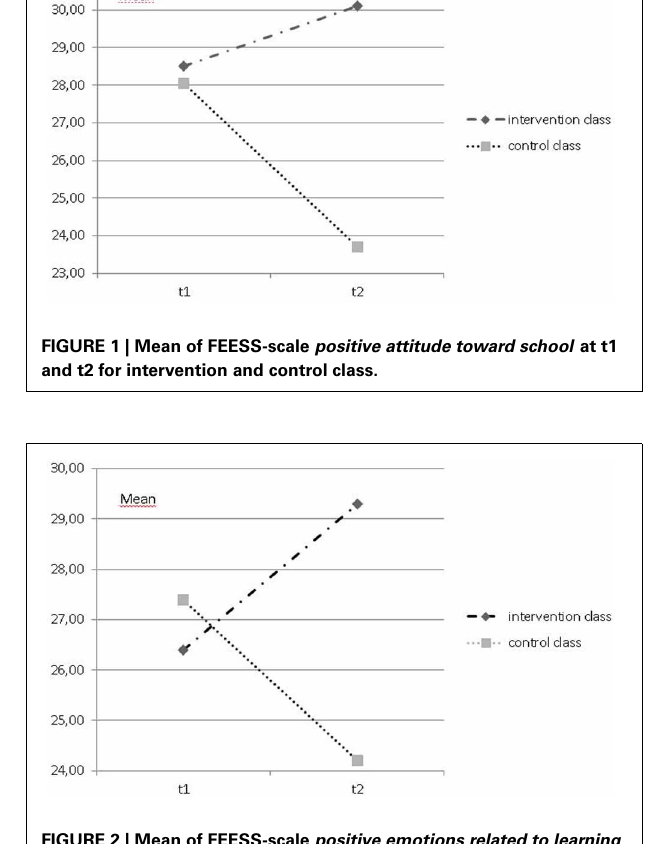
FIGURE 2 | Mean of FEESS-scale positive emotions related to learning at t1 and t2 for intervention and control class.